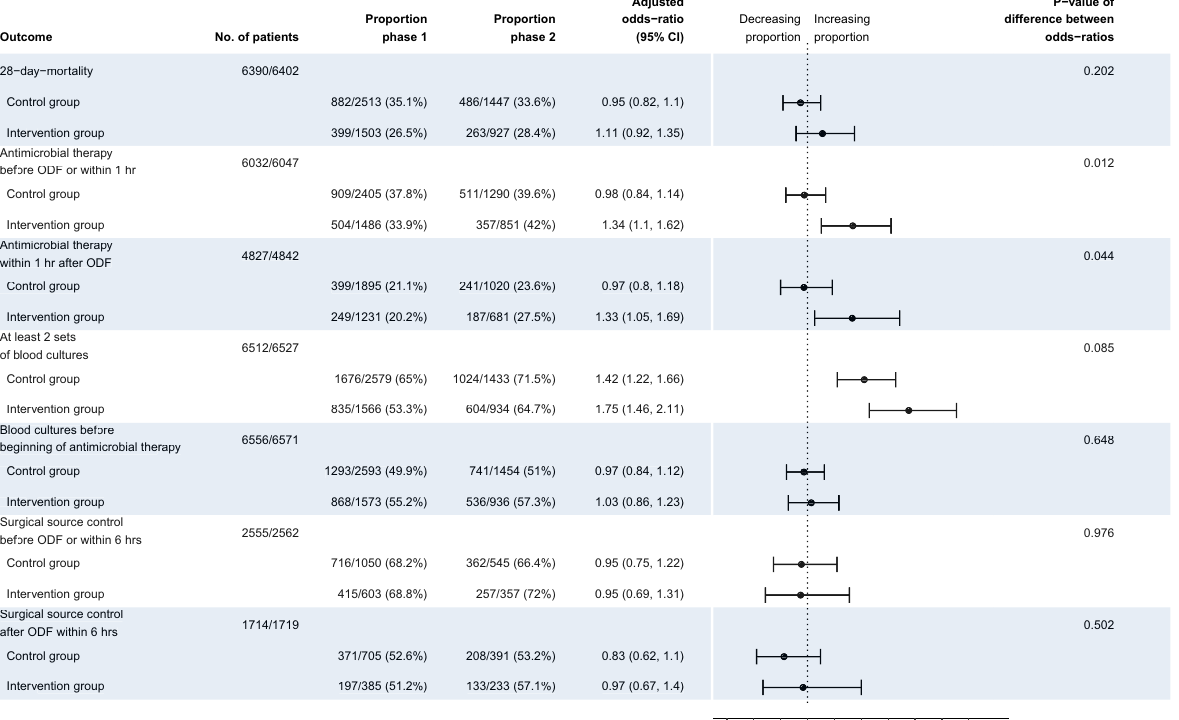
Supplementary Figure S4 presents the quarterly course of outcomes during the trial. The proportion of antimi- crobial therapy within 1 h increased in the intervention group during the first year of the implementation phase with a tendency to drop again in the second year. Proportion of having taken at least two sets of blood cultures improved quickly and remained high both in control hospitals during phase 1 and intervention hospitals during phase 2. Proportion of appropriate initial antimicrobial therapy and proportion of de-escalation within 5 days were consistently higher during phase 2 in intervention compared to control hospitals. Results of process evaluation. Table 2 shows topics discussed during educational sessions of study coor- dinators with QI teams as well as aims set in these meetings. The meetings had a great focus on building and improving the structures and processes for quality management (e.g., improving the quality of data documenta- tion, involving additional departments in the QI process, improving meeting-frequency, staffing and coordina- tion of the QI team). Regarding actual quality improvement activities, staff education, management of blood cultures and antimicrobials, and in-depth analysis of problems of care were most prominent. The improvement of surgical focus control was never documented as a topic of discussion or aim. The documentation of meetings was not suitable to analyze the degree of achieving the aims set. Table 3 presents barriers to implementation of QI as perceived by study coordinators and QI team members. The reported barriers showed overlap indicating (a) insufficient resources in time and manpower both in the QI team as well as among hospital staff in general, (b) insufficient involvement of departments outside the ICU and of nurses in the QI process, and (c) reduced quality of audit and feedback because of low and infrequent inclusion of cases by the hospitals.